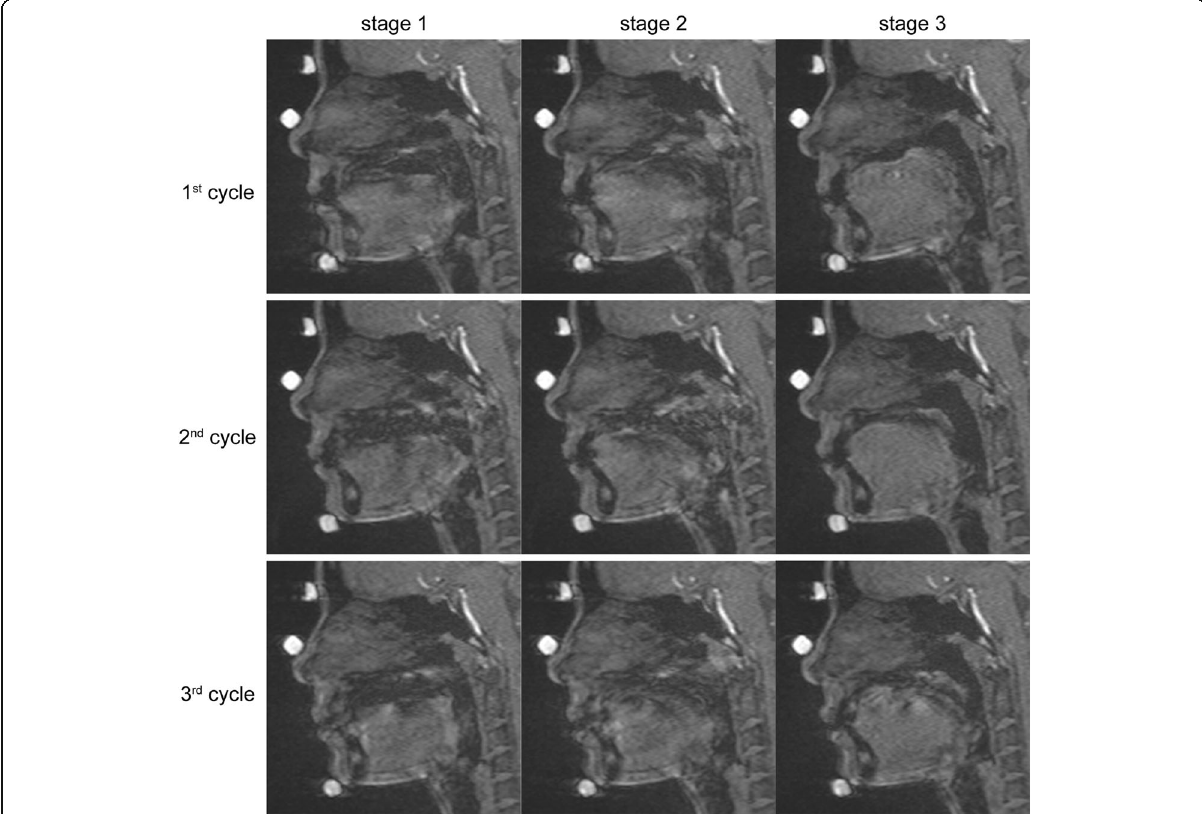
Fig. 4 Acquired images of three cycles of stage 1, stage 2, and stage 3 deglutition. Three cycles were taken at 0 ms, 90 ms, and 270 ms,